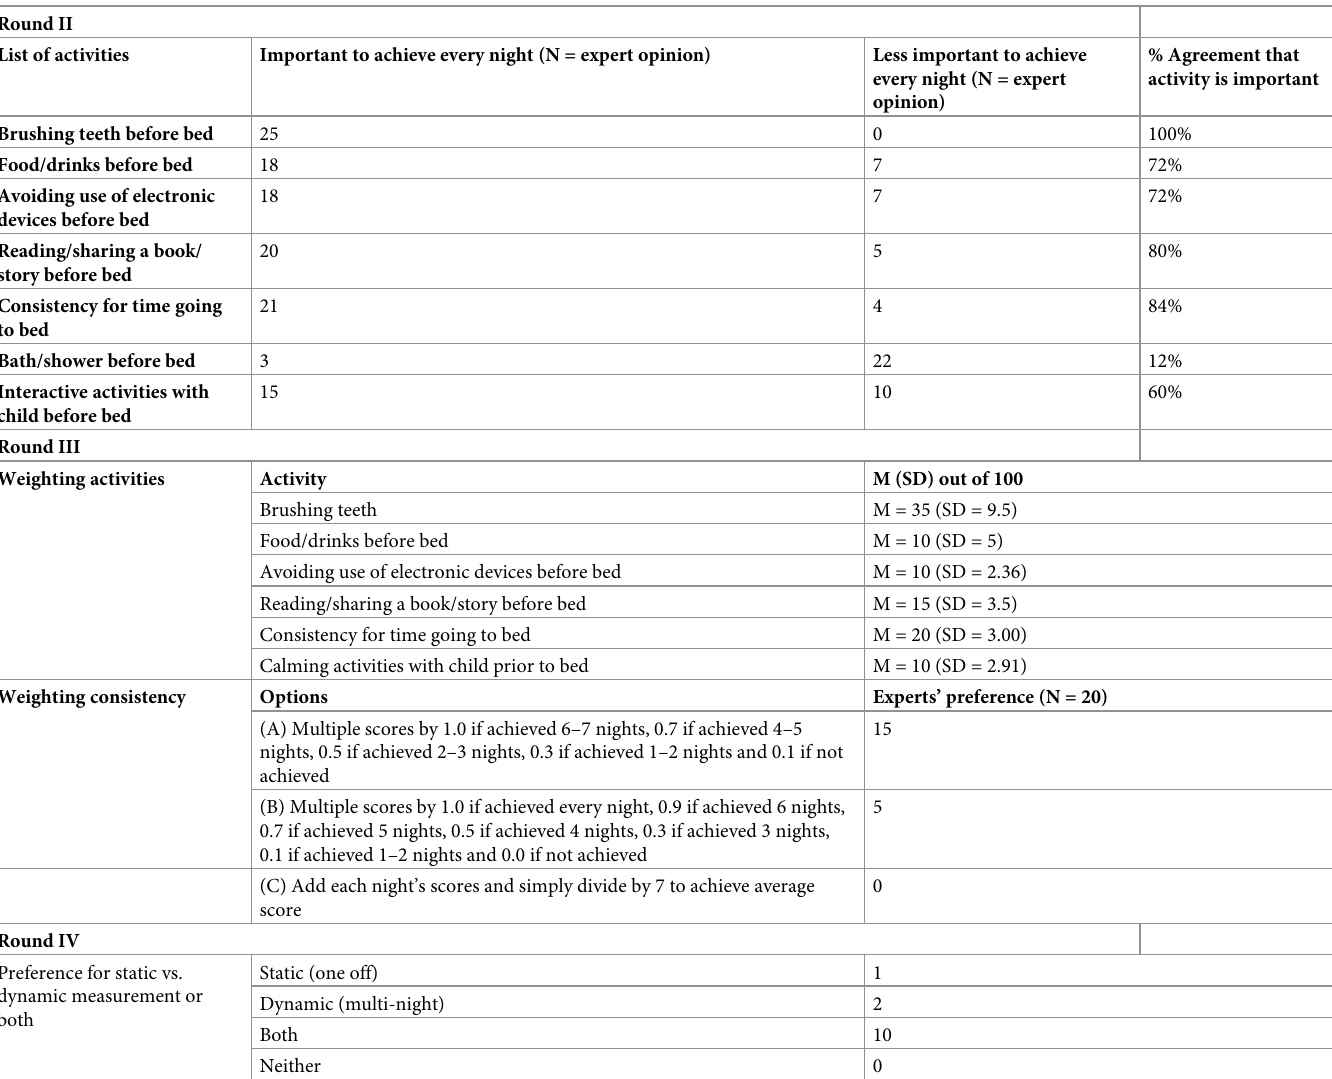
Table 2. Measuring bedtime